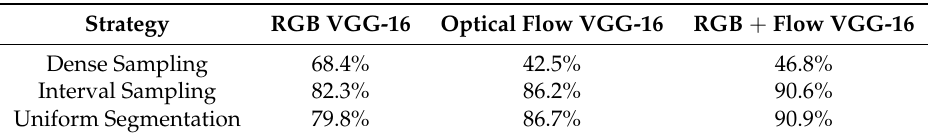
Table 1. Classification accuracies by using different sampling strategies for different CNNs on the UCF-101 dataset